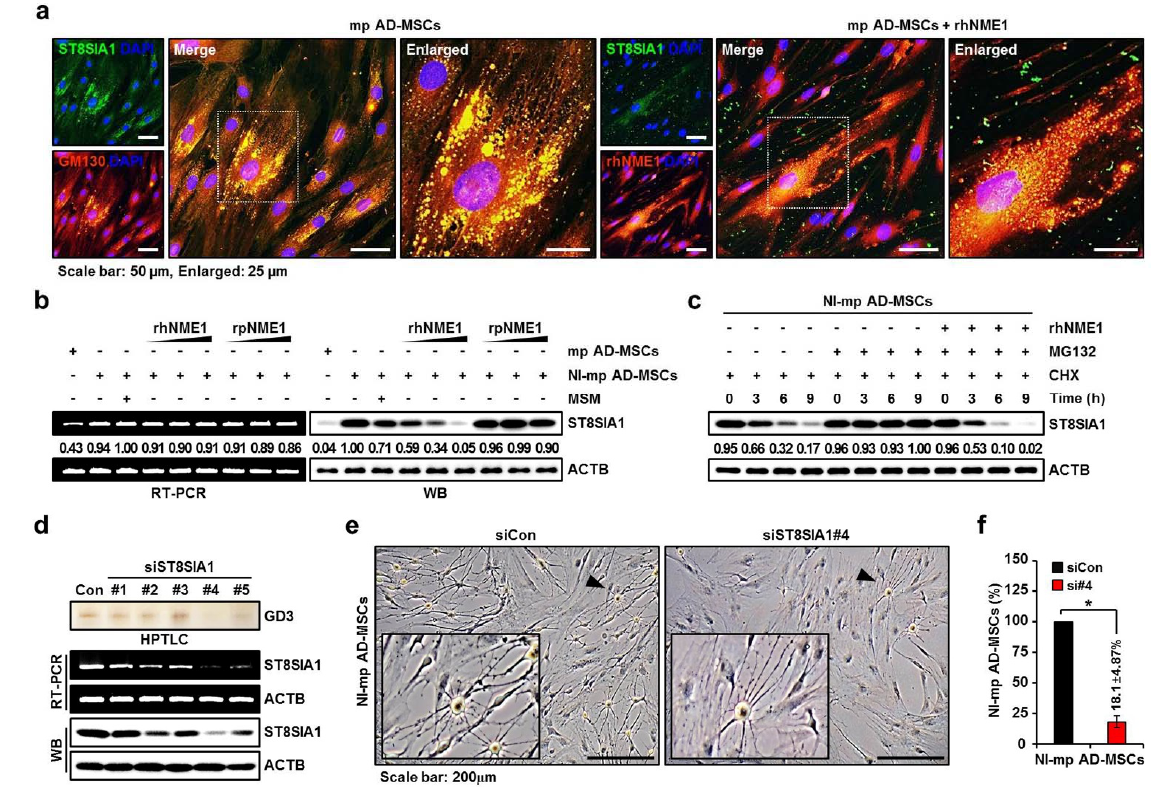
Figure 5. Immunocytochemistry of mp AD-MSCs with and without rhNME1 treatment. ( a ) Co-localization of endogenous ST8SIA1 in the Golgi apparatus in mp AD-MSCs or endogenous ST8SIA1 with exogenous rhNME1. Immunofluorescence microscopy results show mp AD-MSCs fixed and stained with antibodies against ST8SIA1 (green), cis-Golgi marker GM130 (red), and ectopic His-tagged rhNME1 (red). DAPI was used for nuclear counter staining. Overlapping staining (yellow) demonstrates the co-localization of the two proteins, and white squares indicate enlarged merged images. ( b ) Reduction in ST8SIA1 expression by rhNME1, rsNME1, and MSM treatment in mp AD-MSCs or NI-mp AD-MSCs. RT-PCR (left panel) and Western blots (right panel) for ST8SIA1 protein in rhNME1 or rsNME1-treated NI-mp AD-MSCs. Only rhNME1 (1, 2, and 4 ng/mL), not rsNME1, dose-dependently significantly decreased ST8SIA1 protein levels in NI-mp AD-MSCs; neither rhNME1 nor rsNME1 suppressed ST8SIA1 mRNA in NI-mp AD-MSCs. ACTB was used as a loading control. ( c ) ST8SIA1 is regulated by the proteasome and rhNME1. Western blot analysis determined the effects of rhNME1, MG132, and cycloheximide on ST8SIA1 protein accumulation. Protein extracts were prepared from NI-mp AD-MSCs treated with rhNME1 (4 ng/mL) or MG132 (10 uM), cycloheximide (150 nM), or a combination of the two. Equal protein loading was confirmed with ACTB antibody. ( d ) The knockdown of ST8SIA1 siRNA. ST8SIA1-specific siST8SIA1 or siCon was transfected into mp AD-MSCs. After transfection with siST8SIA1 (50 nM) for 48 h, ST8SIA1 expression was evaluated using HPTLC, RT-PCR, and Western blotting. ACTB was used as a loading control. All siRNA sequence information is provided in Supplementary Figure S4 and Table S3. #, siRNA number. ( e ) Phase-contrast images of transfected NI-mp AD-MSCs with siCon or siST8SIA1 (#4). Arrowheads indicate enlarged images. ( f ) Variations in the cell count of NI-mp AD-MSCs were quantified for NI-mp AD-MSCs transfected with siCon or siST8SIA1#4 (si#4). Data are presented as mean percentage levels ± SD ( n = 3; * p < 0.05).